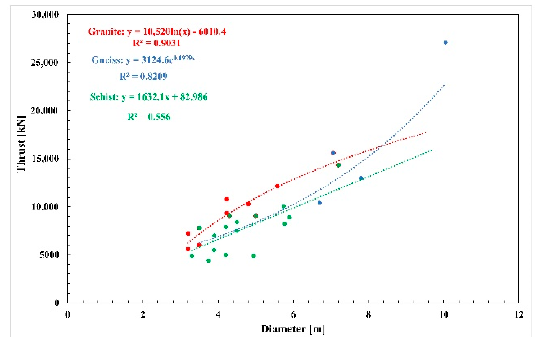
Figure 9. Correlation between the diameter and the thrust due to the excavation in granites, gneisses and schists by open TBMs.